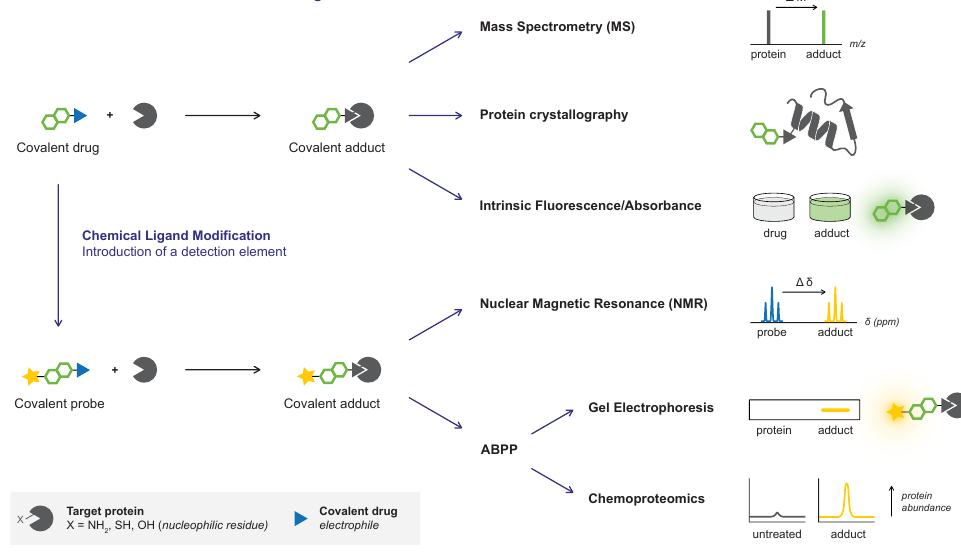
Figure 1. Validation of a covalent binding mode by direct detection of the covalent protein–drug